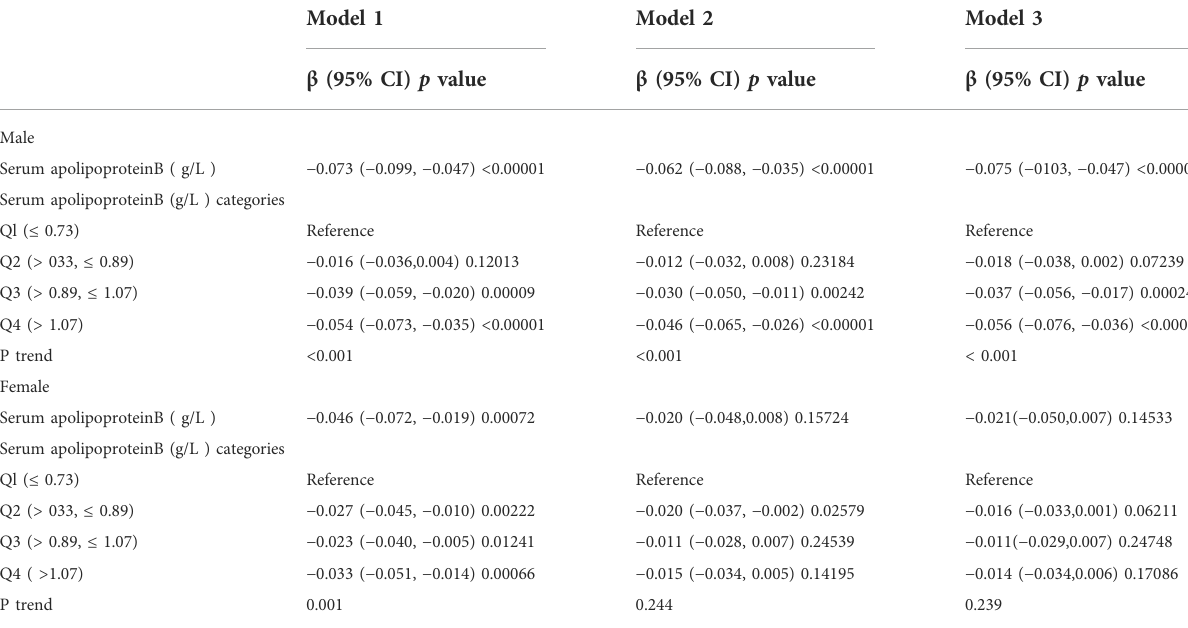
TABLE 3 Association between Serum apolipoprotein B (g/L ) and lumbar bone mineral density (subgroup analysis strati fi ed by Sex).